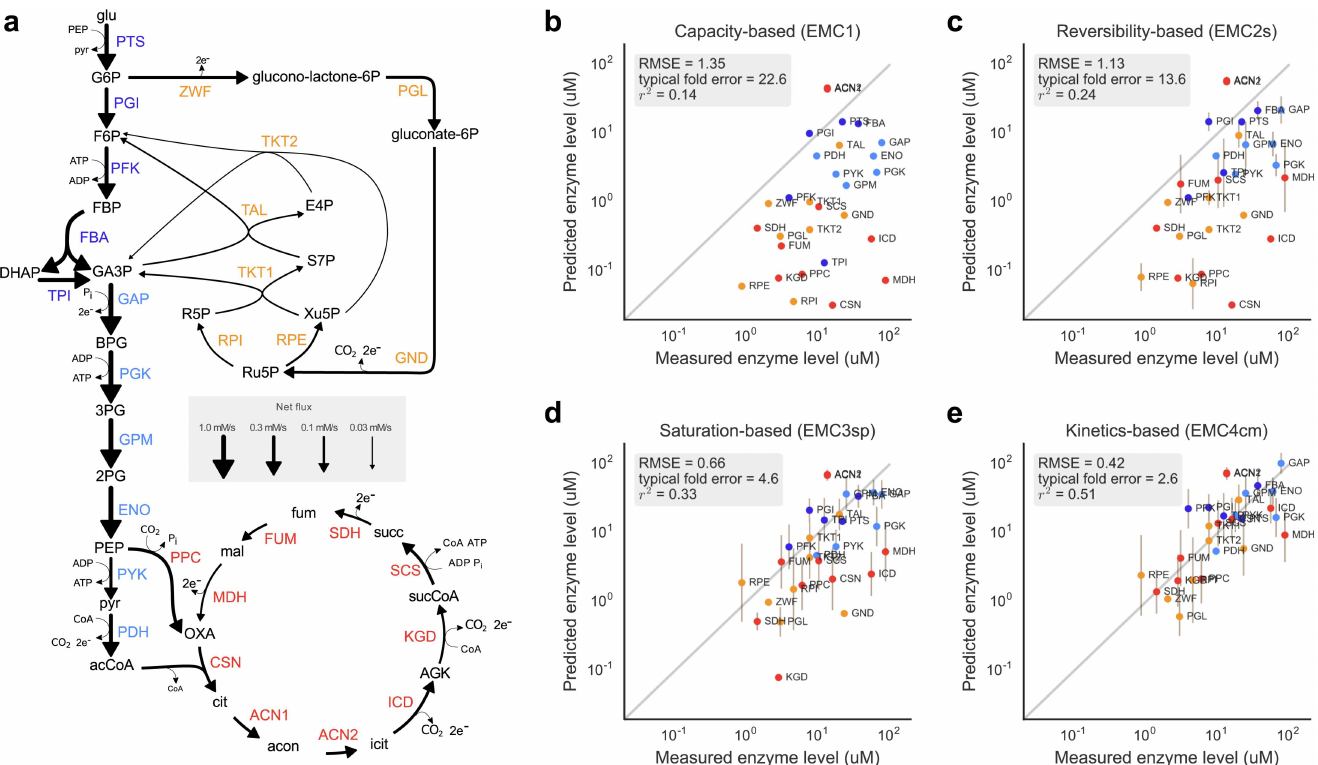
Fig 3. Predicted enzyme levels in E. coli central metabolism. (a) Network model with pathways marked by colors. Flux magnitudesare represented by the arrows’ thickness. (b) The ratio flux/ k þ (EMC1) as a predictor for enzyme levels. Points on the dashedline would represent precise predictions. (c) cat Enzyme levels predicted by the reversibility-based EMC2(S) function. Vertical bars indicate tolerance ranges obtained from a relaxedoptimality condition (allowingfor a one percent increase in total enzyme cost). (d) Enzyme levels predicted with EMC3 function representing fast substrate or product binding.(e) Enzyme levels predicted with EMC4 function based on the common modular rate law [21]. In all sub-figures (b-e), RMSE is the root mean squarederror (in log 10 -scale) of our predictions comparedto the measuredenzyme levels, and r stands for the Pearson correlationcoefficient. Predictions are based on fluxes from [52], k þ and K M values from BRENDA [40], and comparedto protein data from [53]. For metabolite predictions, see cat Figure E in S1